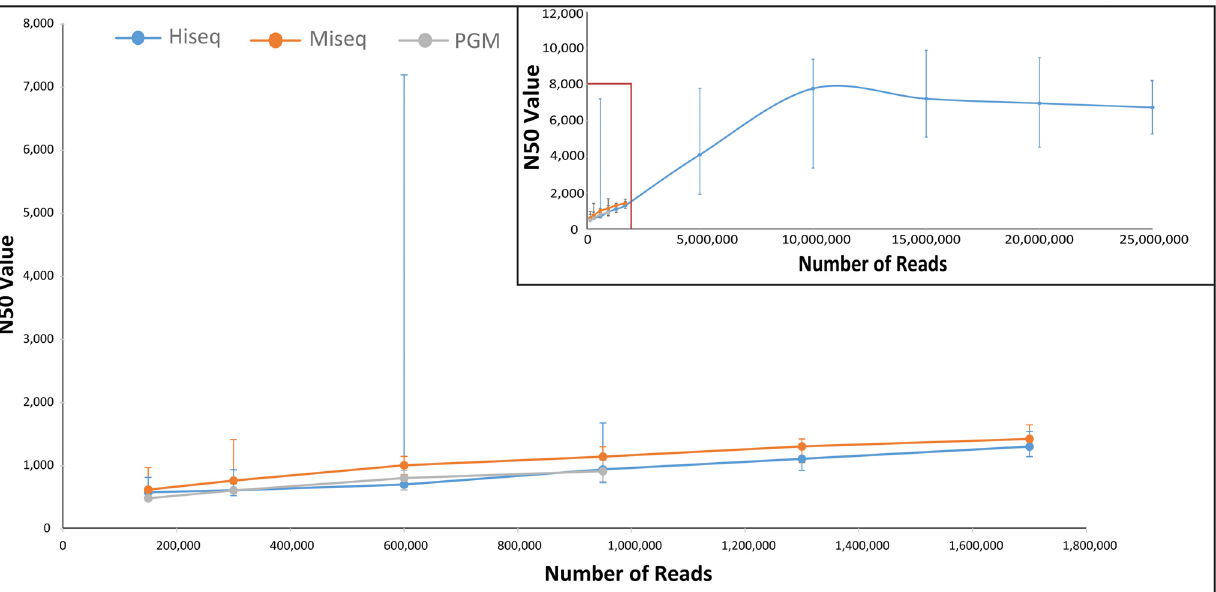
Fig 4. N50 values representing randomly subsampled reads at various sequencing depths after assembly by IDBA_UD. Each point represents the median value across each of the 6 samples per technology (including 3 replicates per sample). Error bars are the 25% and 75% quartile ranges.